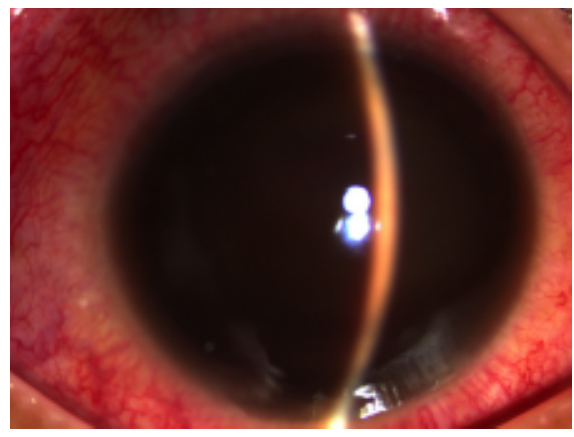
Figure 1: Slitlamp examination of the right eye on initial consult The patient was then assessed as a case of periorbital hematoma, traumatic hyphema with corneal staining of the right eye, with lens dislocation and subretinal hemor-